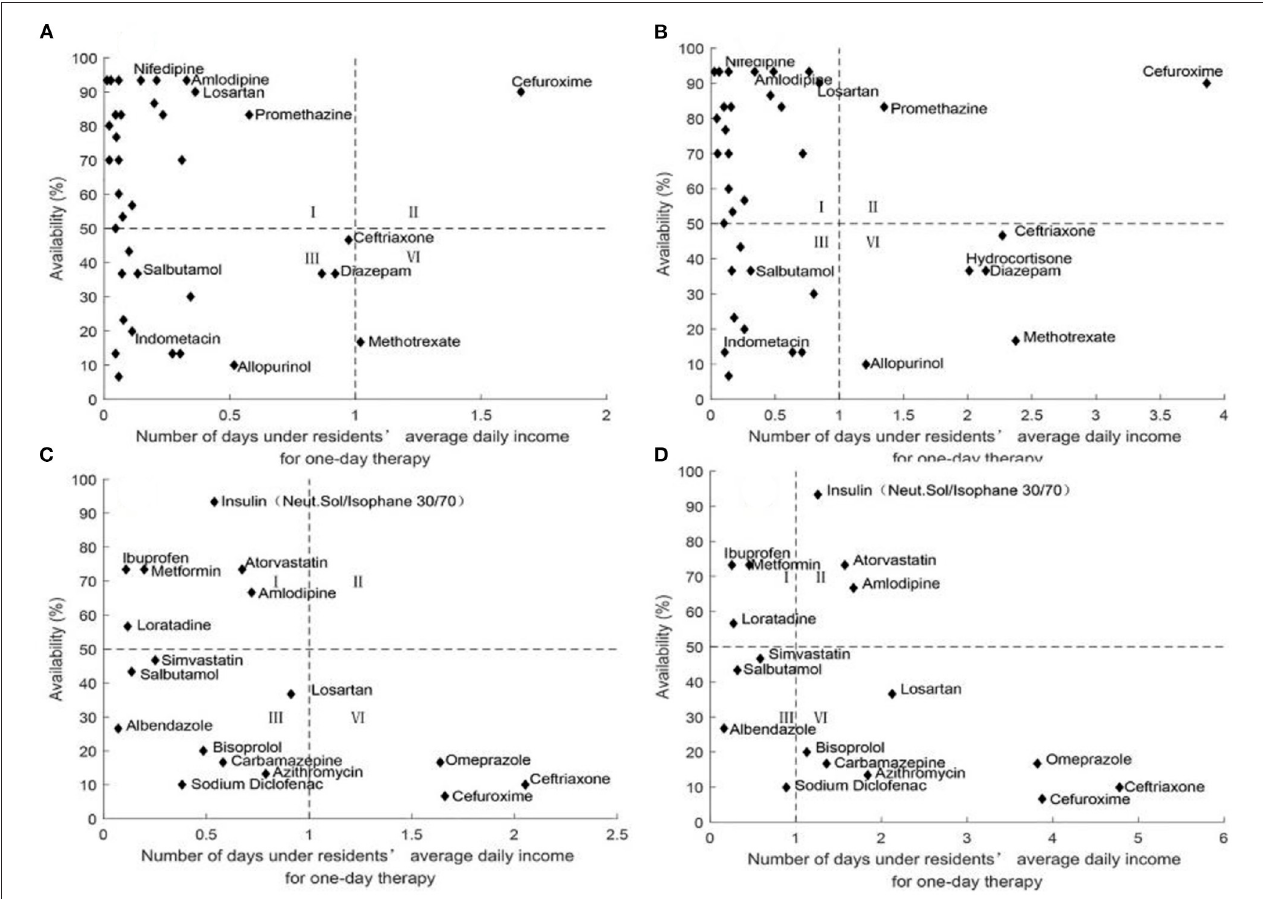
FIGURE 5 | Comprehensive analysis of medicine availability and affordability in 2019. (A) Comprehensive analysis of LPGs availability and affordability for urban residents. (B) Comprehensive analysis of LPGs availability and affordability for rural residents. (C) Comprehensive analysis of OBs availability and affordability for urban residents. (D) Comprehensive analysis of OBs availability and affordability for rural residents.